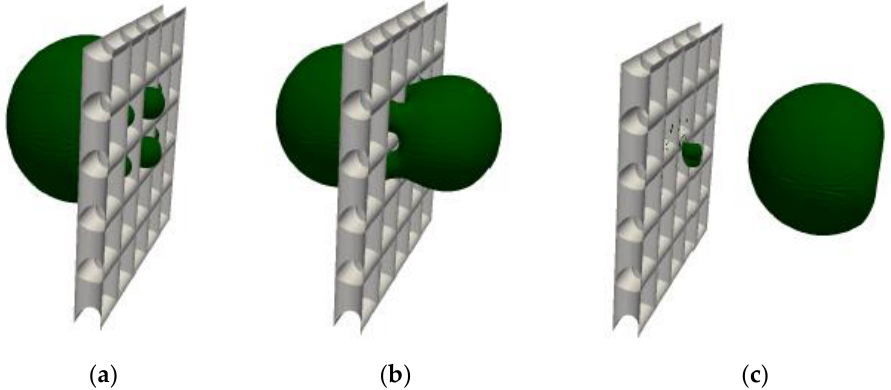
Figure 19. Breakthrough mechanism of a water droplet through a wire mesh screen. ( a ) Sub-drop- lets start to form through clogged pores; ( b ) Coalescence of sub-droplets; ( c ) Breakthrough the wire mesh screen and the droplet is transported downstream.